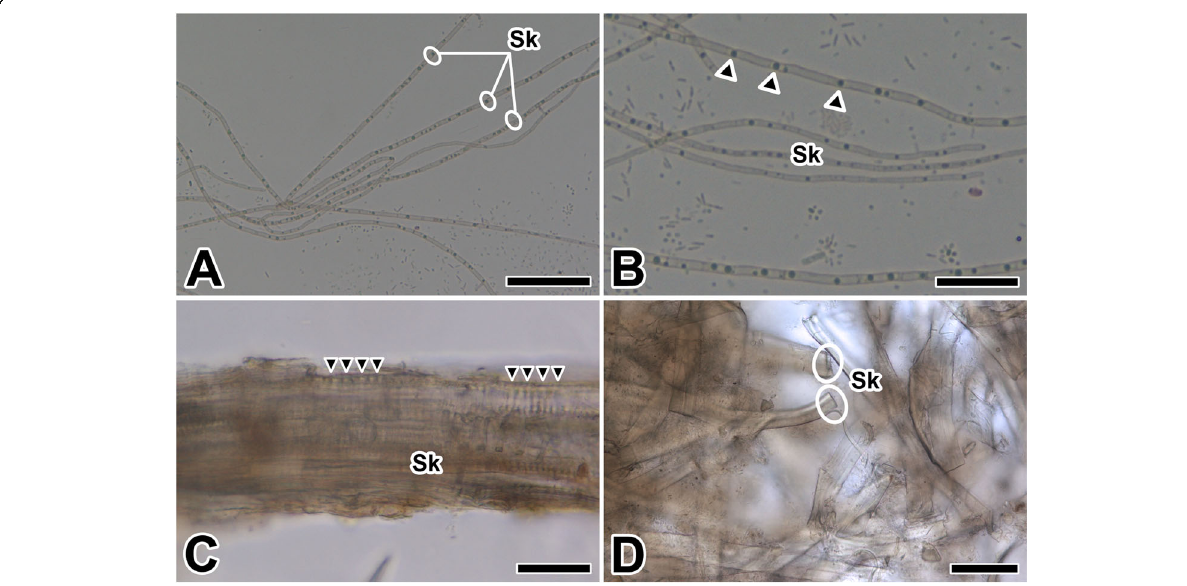
Fig. 5 Photo micrographs of the silk fibers in the caddisworm H. nigrovittatus. a , b Each silk fiber (Sk) shows peculiar banding pattern as alternating dark (arrowheads) and light bands. c , d The alignment of fibers in the silken case causes the entire silk ribbon to appear striated (arrowheads). Scale bars indicate 50 μ m ( a ), 25 μ m ( b ), 10 μ m ( c ), and 5 μ m ( d ),